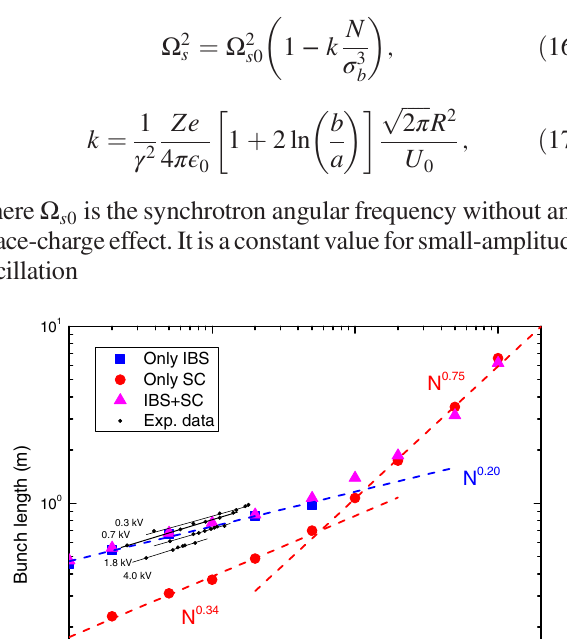
FIG. 7. Comparison of the bunch length between simulation and experiment. The dashed lines are fitted to the simulation results. 112 Sn 36 þ and 12 C 6 þ beams, respectively. The parameters used in the simulation are listed in Table IV.